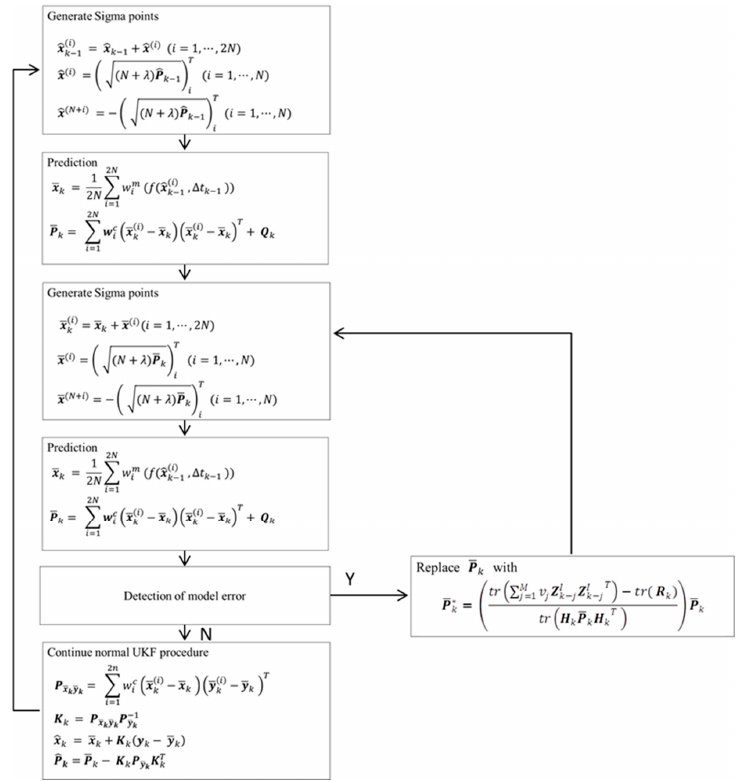
Figure 1. Algorithm of the proposed method.